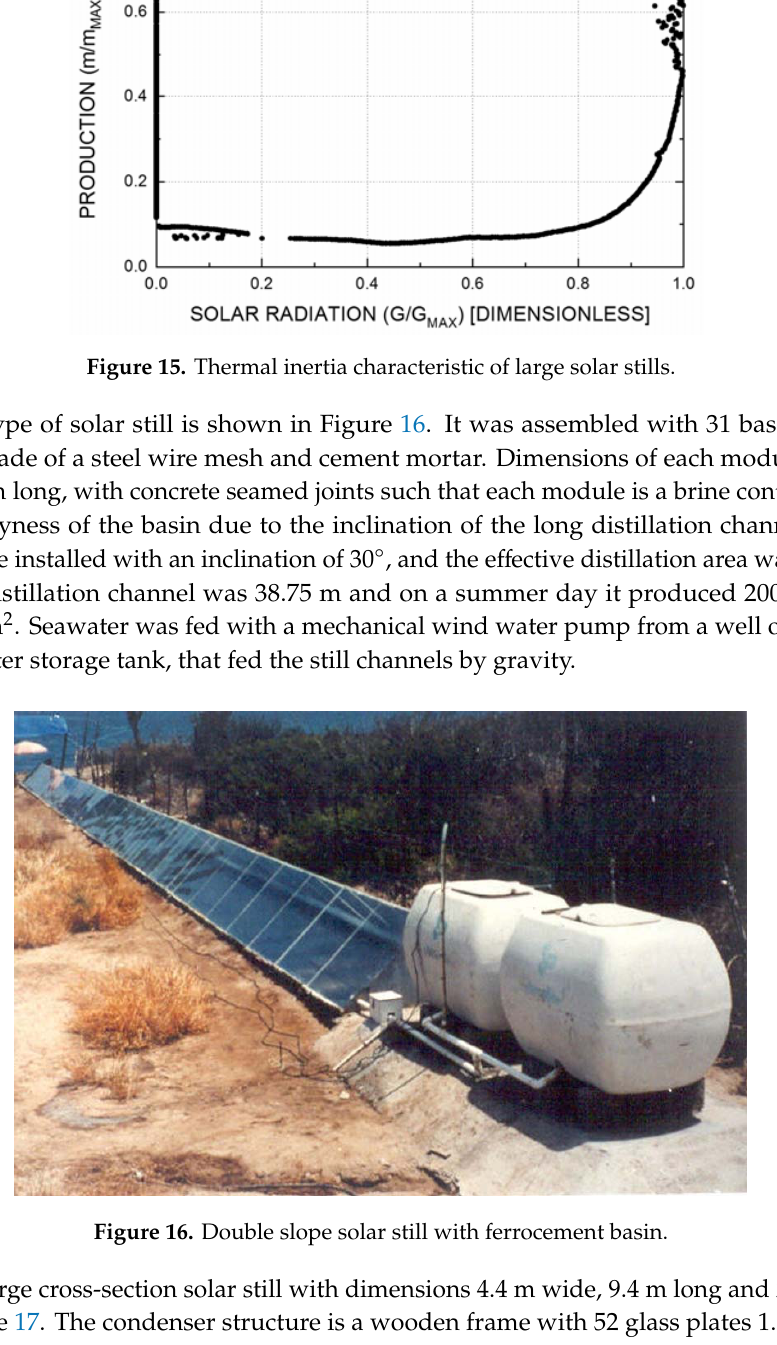
Figure 14. Orientation ‐ adjustable large cross ‐ section solar still for outdoor experimentation.